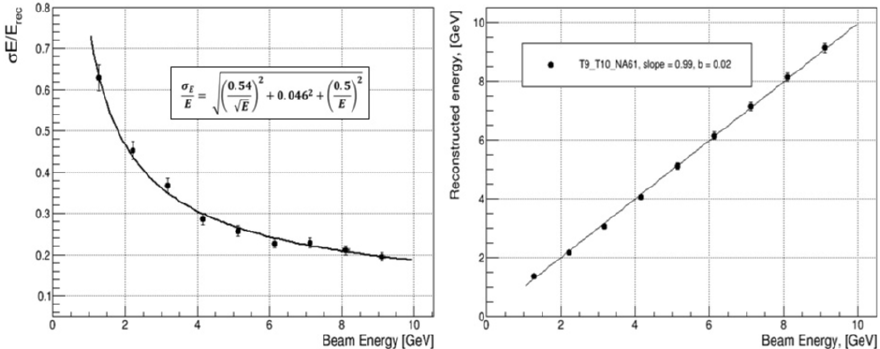
Figure 4. The measured supermodule energy resolution and linearity response are shown in the left and in right figures,